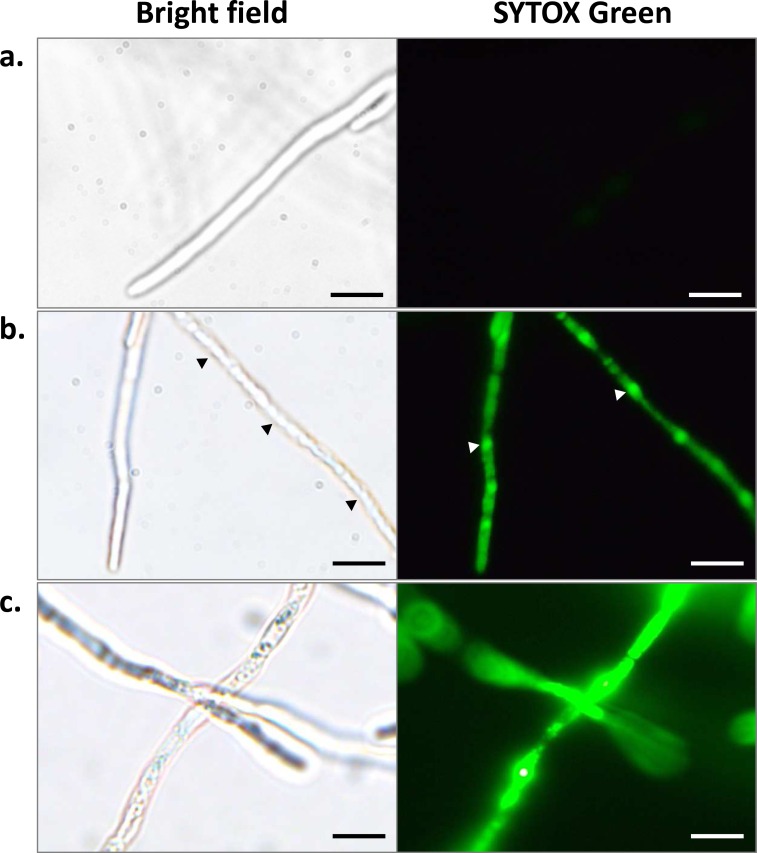
SYTOX green (0.5 μM) uptake into hyphae treated with 50 μg/ml pterostilbene.Bright field and fluorescent images for (a) control, (b) hyphae treated for 2 hours and (c) 4 hours. Black arrowheads indicate coagulation of the cytosol within the cytoplasm. White arrowheads indicate SYTOX green staining in the nuclei. Scale bar = 20 μm.